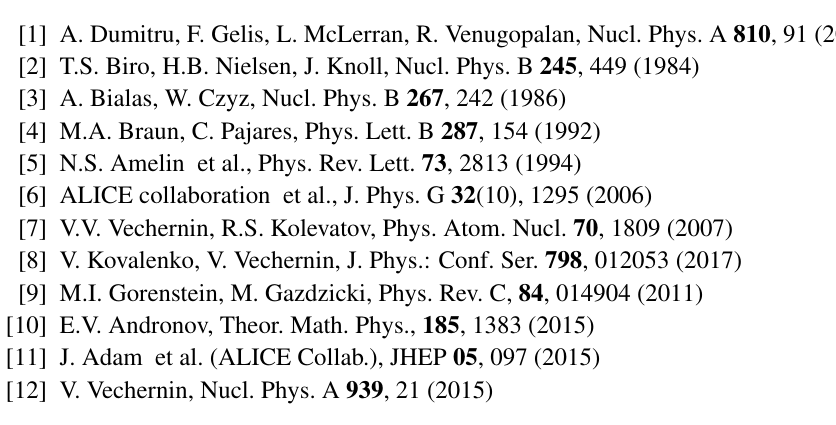
Figure 2. The charge-wise strongly intensive variables Σ ( n + Σ ( n + , n − ) ≡ Σ + − ( ∆ η ) (dash-dotted line) for the case of two small observation windows as a function F B of rapidity gap ∆ η between them. These variables were calculated using Eqs. (12) and (14) with the string correlation functions Λ opp ( ∆ η ) and Λ same ( ∆ η ) obtained with the fit procedure shown in Fig. 1. Full line shows the strongly intensive observable Σ ( n windows given by Eq.